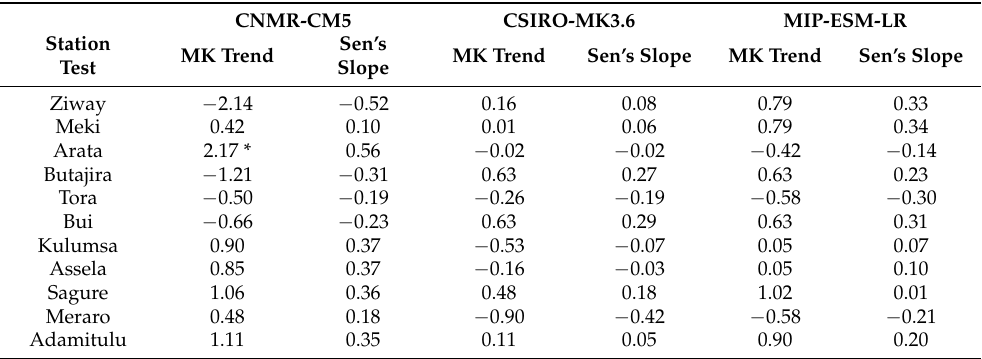
Table 2. Mann–Kendall trend and Sen’s slope estimator value for annual baseline (observed) and historical rainfall within the Ziway Lake Basin from